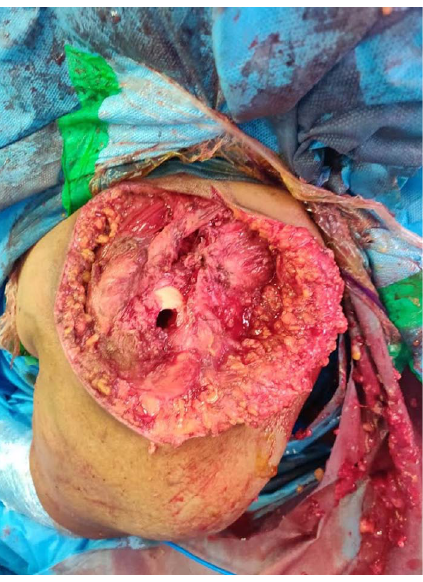
Figure 8. Osteomyelitic nidus retrieved from the humeral head through the debridement hole.